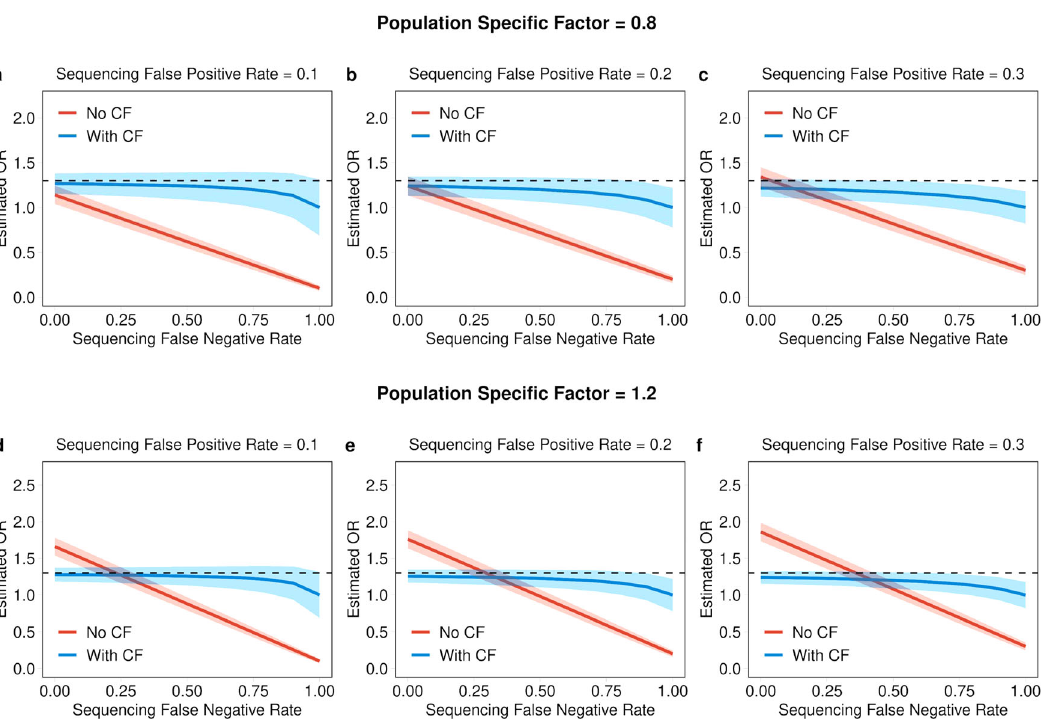
Fig. 2 Simulated effects of combined SFN rate, SFP rate, and PSF on estimated OR. Probability of mutation ( P ) was calculated as a function of the cumulative minor allele frequency for a single gene (CMAF Gene : set at 0.05), the true effect size of association (OR), and the 3 major association biases (SFN, SFP, and PSF) according to Eq. (2). The simulations kept the true OR fi xed at 1.3 (black dashed lines) while varying SFN rate (0 – 1), SFP rate (0.1, 0.2, and 0.3), and modest PSF (0.8 and 1.2). A mean estimated OR was calculated for each P (corresponding to a unique combination of the 3 association biases) and plotted as a function of the combined biases ( a – f ; red lines) across 100,000 simulations. CF values were calculated as the ratio of the P for each estimated OR and the original CMAF Gene according to Eq. (3). Each CF was then used to adjust the CMAF Gene to calculate an adjusted P ( P * ) according to Eq. (4). Using P * , a CF-adjusted mean estimated OR was plotted as a function of the combined biases ( a – f ; blue lines) across 100,00 simulations. All shaded regions correspond to the 95% con fi dence interval for the mean estimated OR. OR indicates odds ratio, CF indicates correction factor, SFN indicates sequencing false negatives, SFP indicates sequencing false positives, PSF indicates population-speci fi c factor. Equations are de fi ned in the Methods section. Source data are provided as a Source data fi